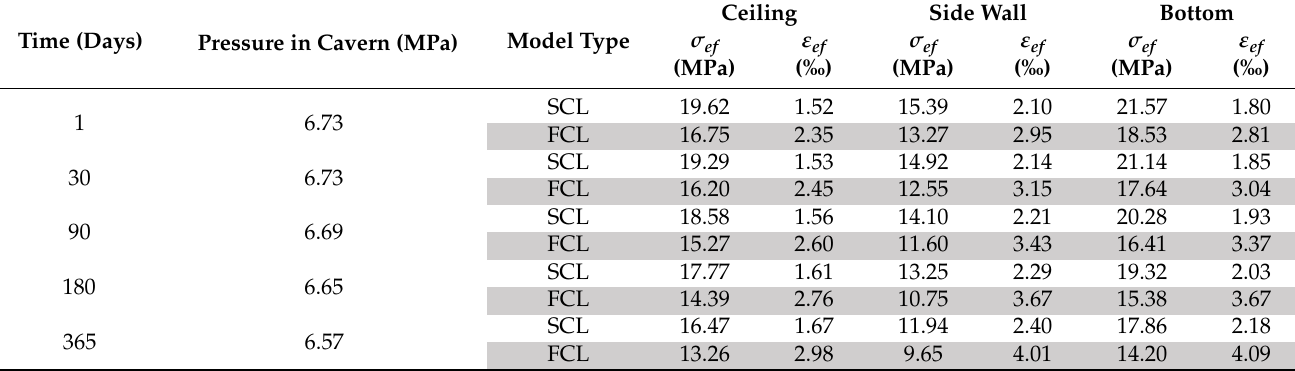
Table 8. Strength criteria for the two2 salt- creep models. Status at the end of a given filling cycle (after injection to the maximum pressure).